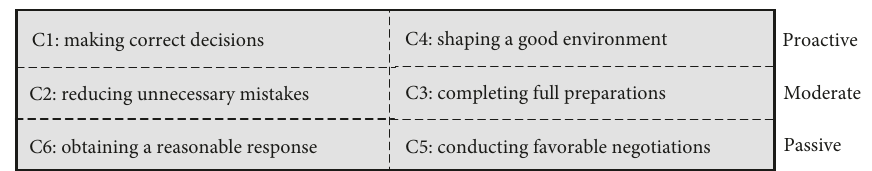
Figure 1: Characteristics of the